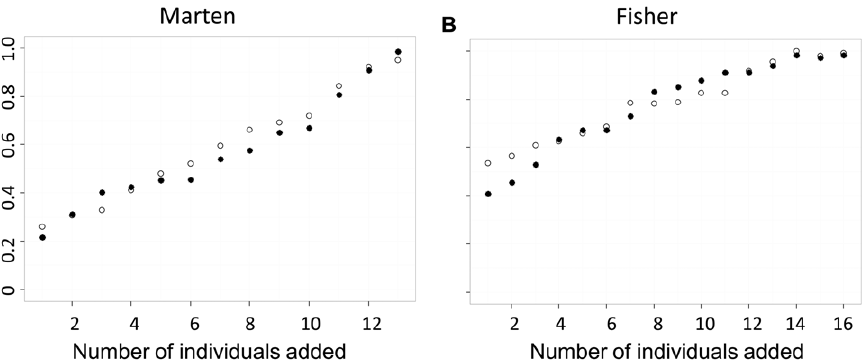
Figure 6. The effect of under-sampled sites on the rank-order of cGD as measured by Spearman ’ s r . Higher values of r indicate fewer deviations in the rank order of cGD compared between each iteration and the true cGD . Each iteration represents the addition of one individual to each site; hollow symbols represent the addition of individuals with common genotypes and filled symbols represent the addition of individuals with rare genotypes.